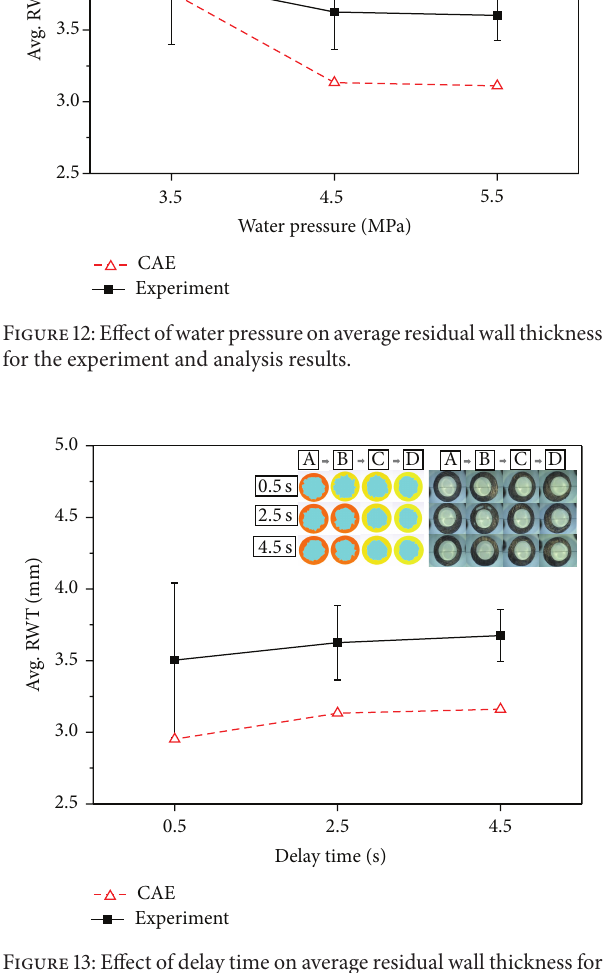
Figure 11: Effect of mold temperature on average residual wall thickness for the experiment and analysis results.